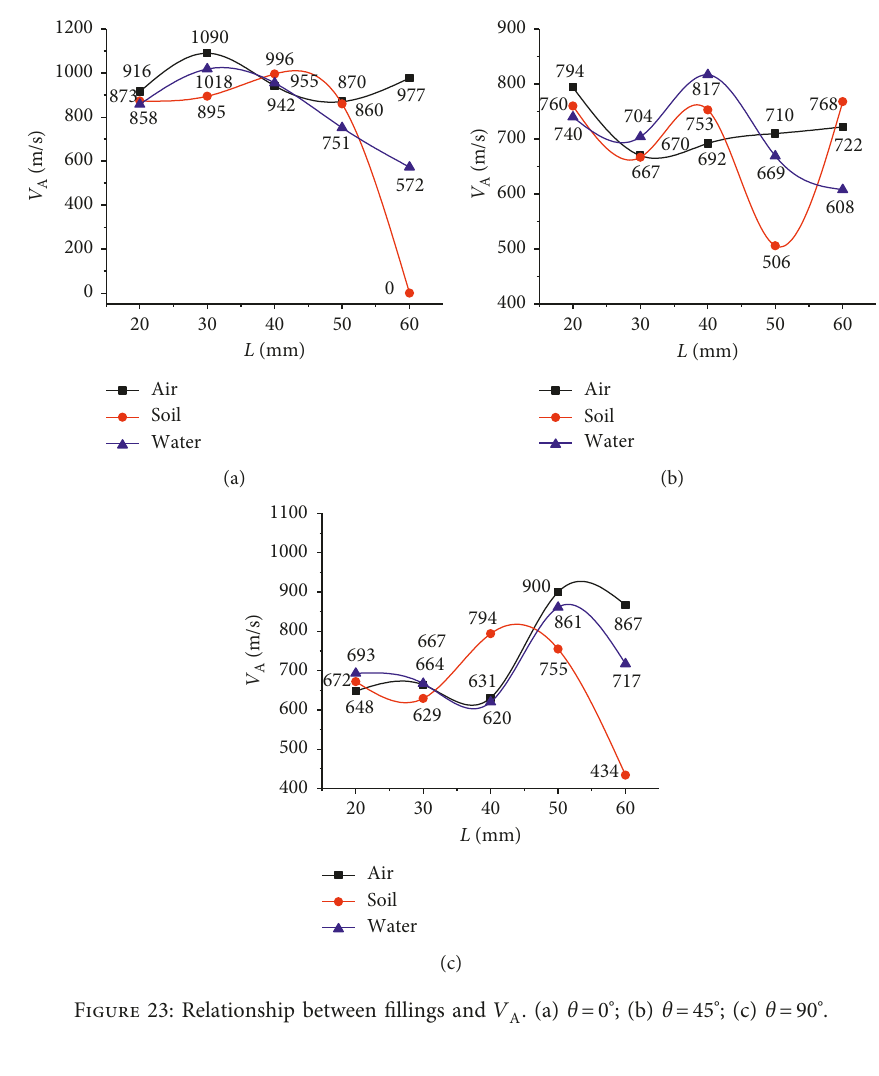
. (a) θ � 0 ° ; (b) θ � 45 ° ; (c) θ � 90 ° . A